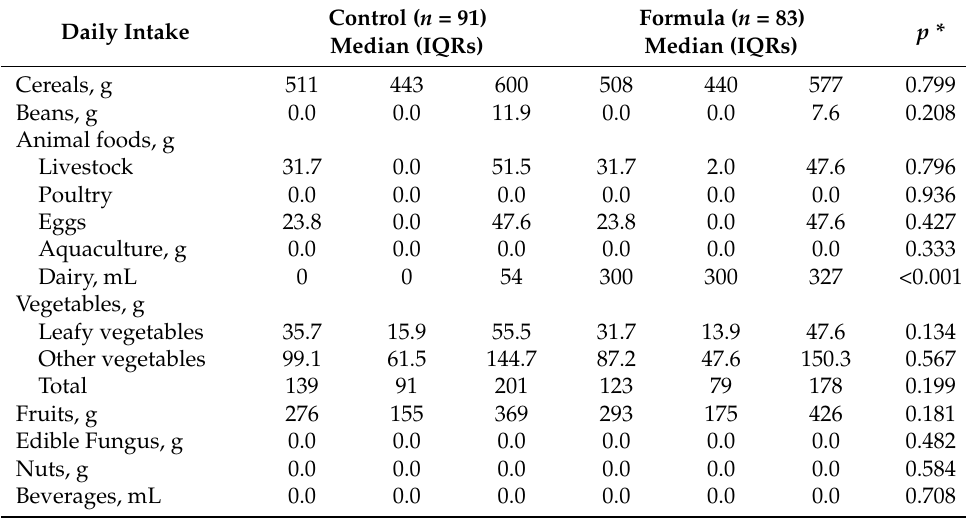
Table 2. Comparison of daily intake of food categories in the formula and control groups during the intervention